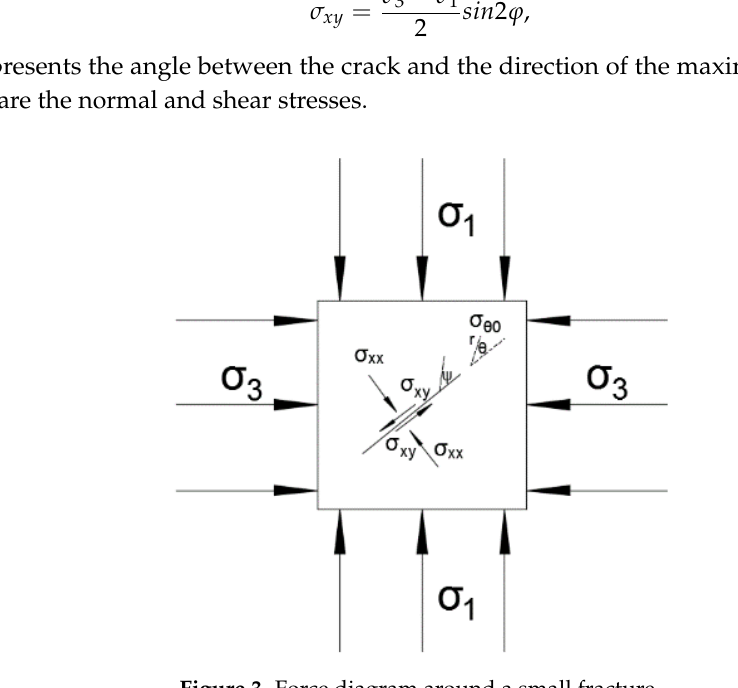
Figure 3. Force diagram around a small fracture.